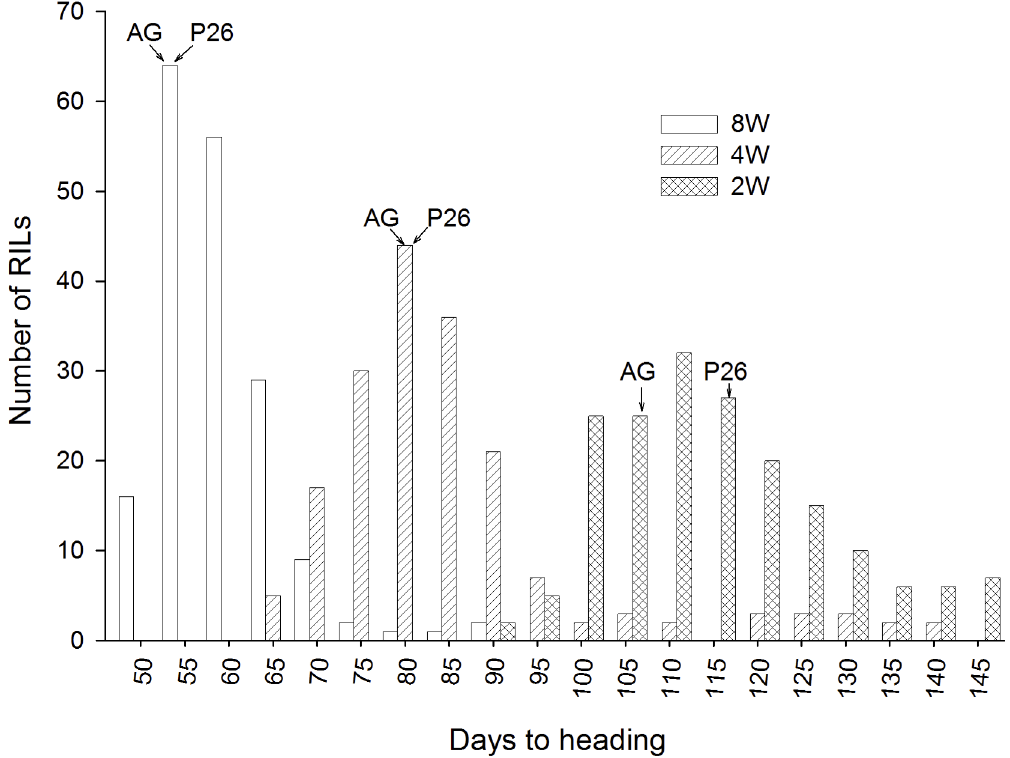
Fig 2. Greenhouse heading dates. Frequency distribution for heading dates of recombinant inbred lines from a cross between AGS 2000 (AG) and 26R61 (P26) after 8 weeks; 8W, 4 weeks; 4W, and 2 weeks; 2W, of vernalization